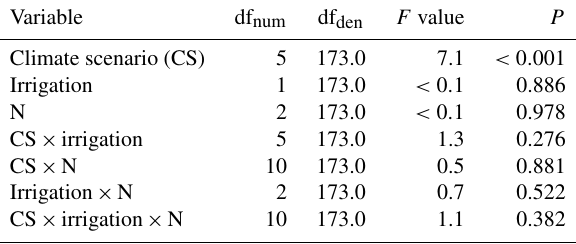
Table B1. Summary of analyses for the effects of climate scenario (CS), irrigation and N deposition on SOC stock change of subalpine grassland between 2012 and 2017. F tests refer to the fixed effects of a linear mixed-effects model; the marginal and conditional R 2 values were 0.19 and 0.33, respectively. The random block variance was estimated to be zero and was therefore removed from the model.